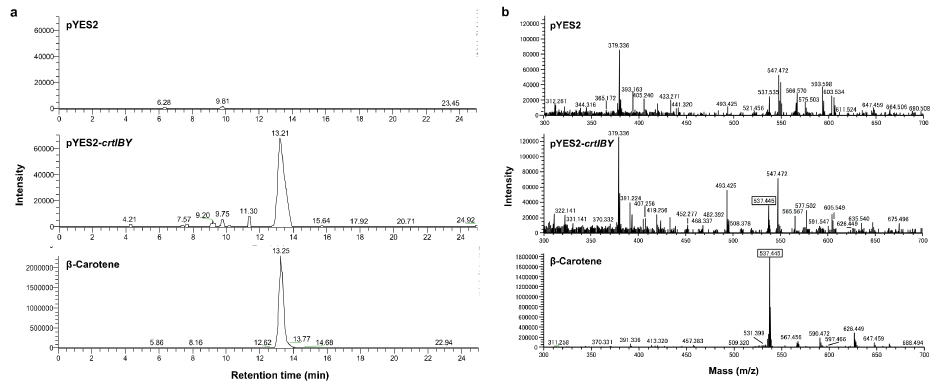
Figure 3. Liquid chromatography–mass spectrometric analyses of carotenoids generated by yeasts expressing crtIBY from Aurantiochytrium sp. KH105. ( a ) Total ion chromatograms of carotenoids extracted from yeast cells carrying pYES2 or pYES2- crtIBY and the β -carotene standard. An ion signal was selected within the molecular weight range of 537.44–537.45; ( b ) Mass spectrometry of carotenoids extracted from yeast cells carrying pYES2 or pYES2- crtIBY and the β -carotene standard at the retention times of 13.35, 13.21, and 13.22 min,